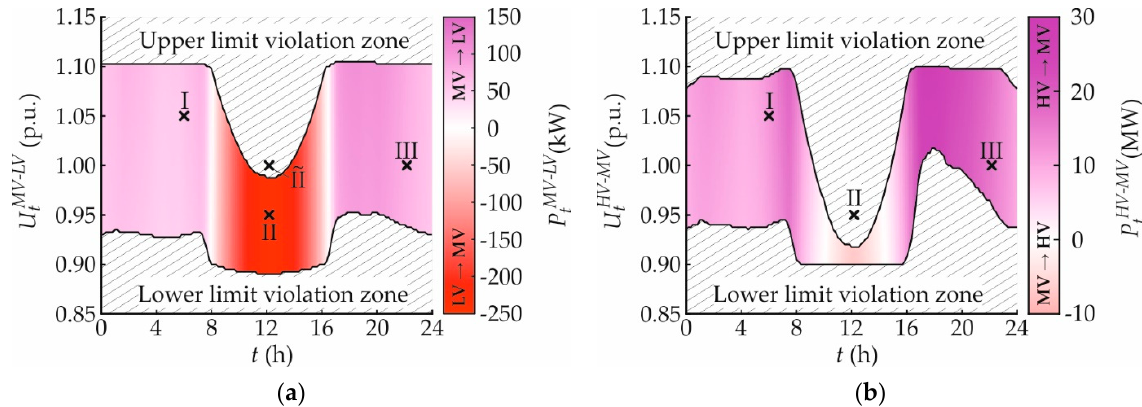
Figure 12. Daily active power exchange over different system boundaries for various boundary voltages and no Volt/var control: ( a ) MV − LV boundary (rural LV_Link-Grid); ( b ) HV − MV boundary.